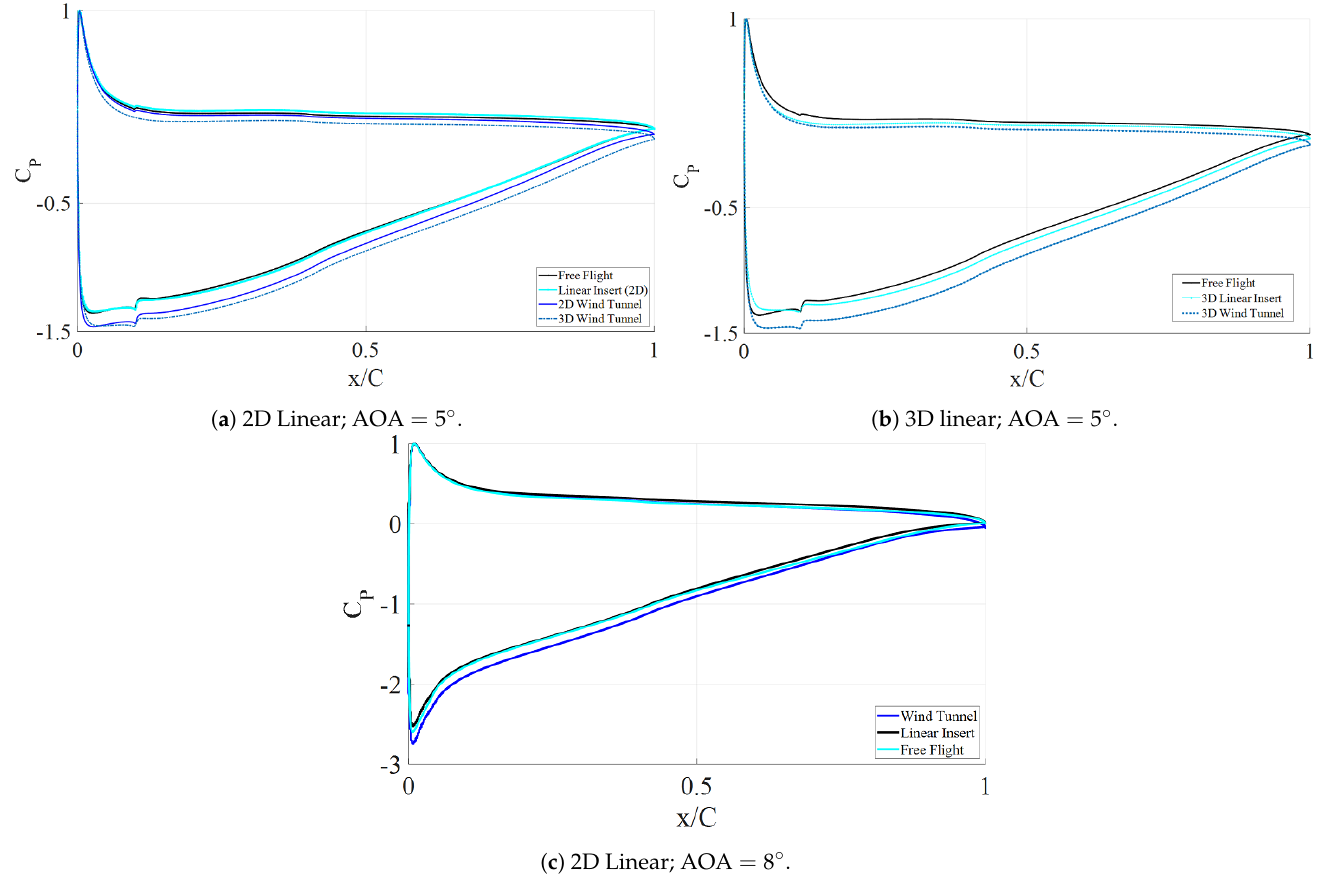
Figure 11. Effect of linear insert on C p . Note that the parallel-wall tunnel is denoted by ‘Wind